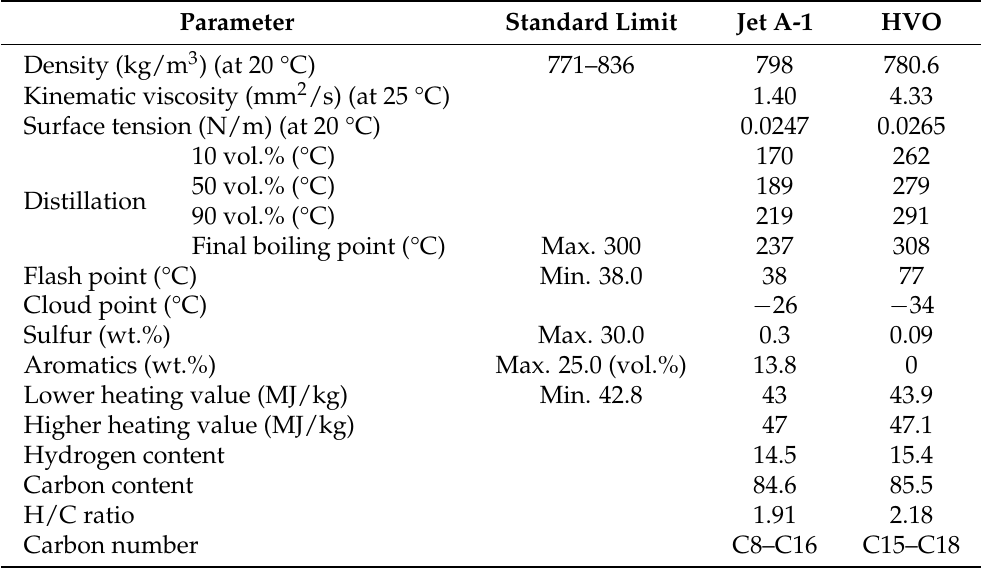
Table 1. HVO and Jet A-1 properties adapted from